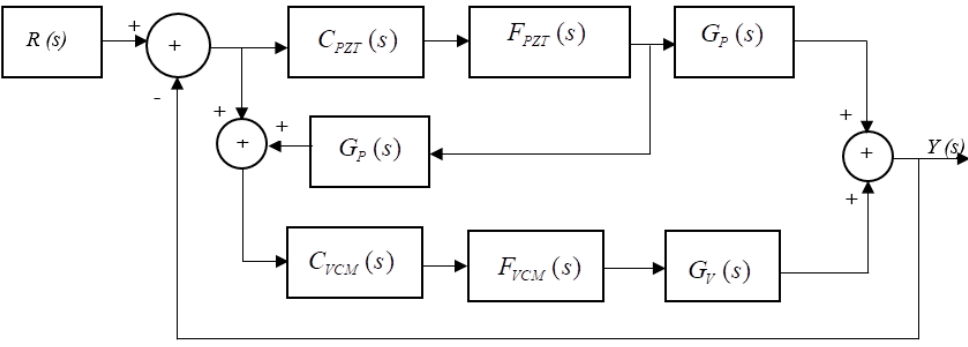
Figure 8. Dual-stage control architecture.